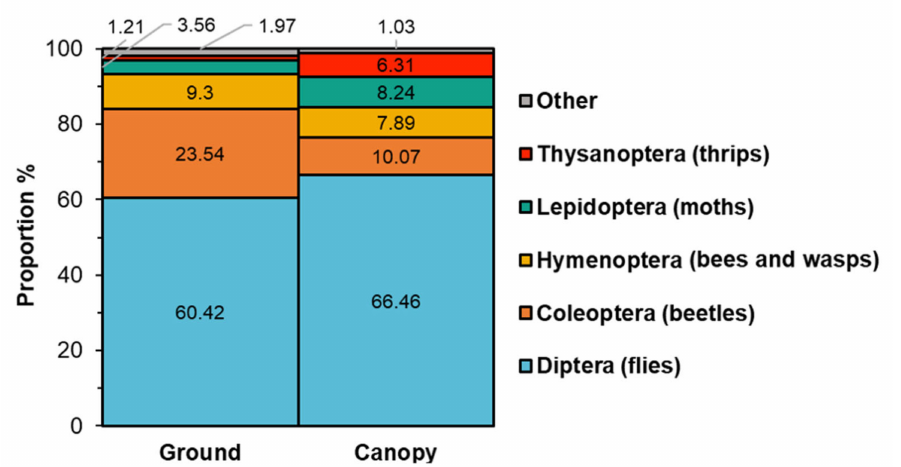
Figure 1. Mosaic chart showing the proportion of insect orders captured in the ground and canopy traps. The total trap captures across all trapping periods on the ground were 3878 (563 per day) and 5655 (822 per day) in the